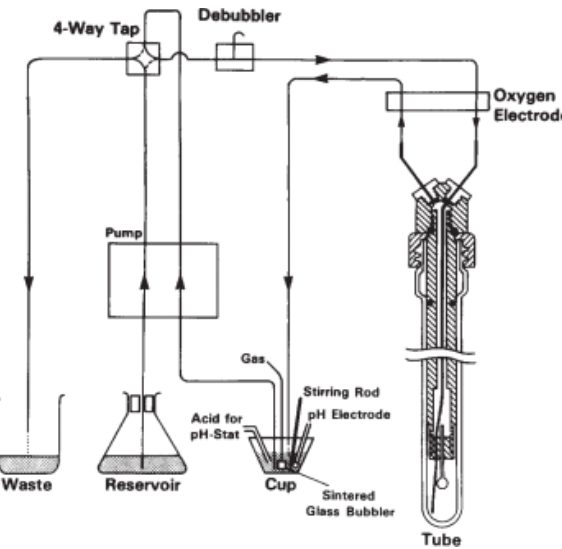
Figure 4. Schematic of the perfusion system showing the arrange- ment of the polyethylene insert. 41